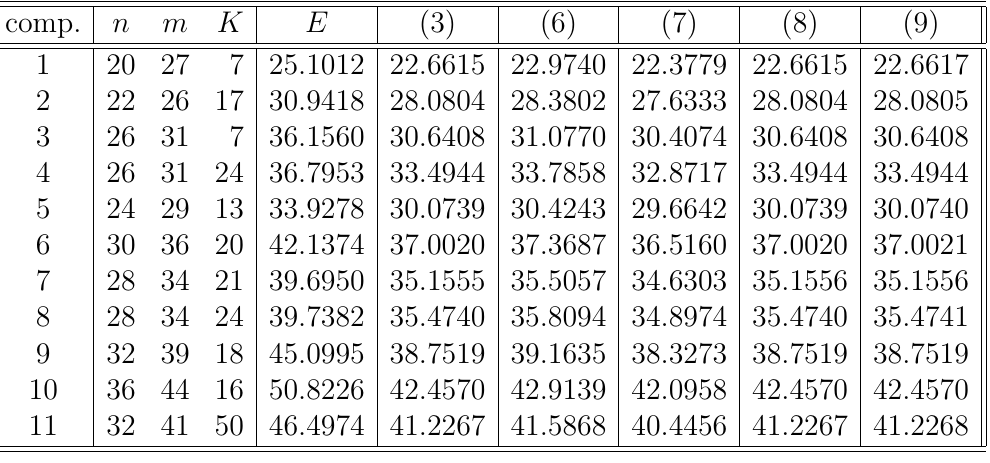
Table 3. Examples illustrating the quality of the lower bounds (3), (6){(9); the compounds same as in Table